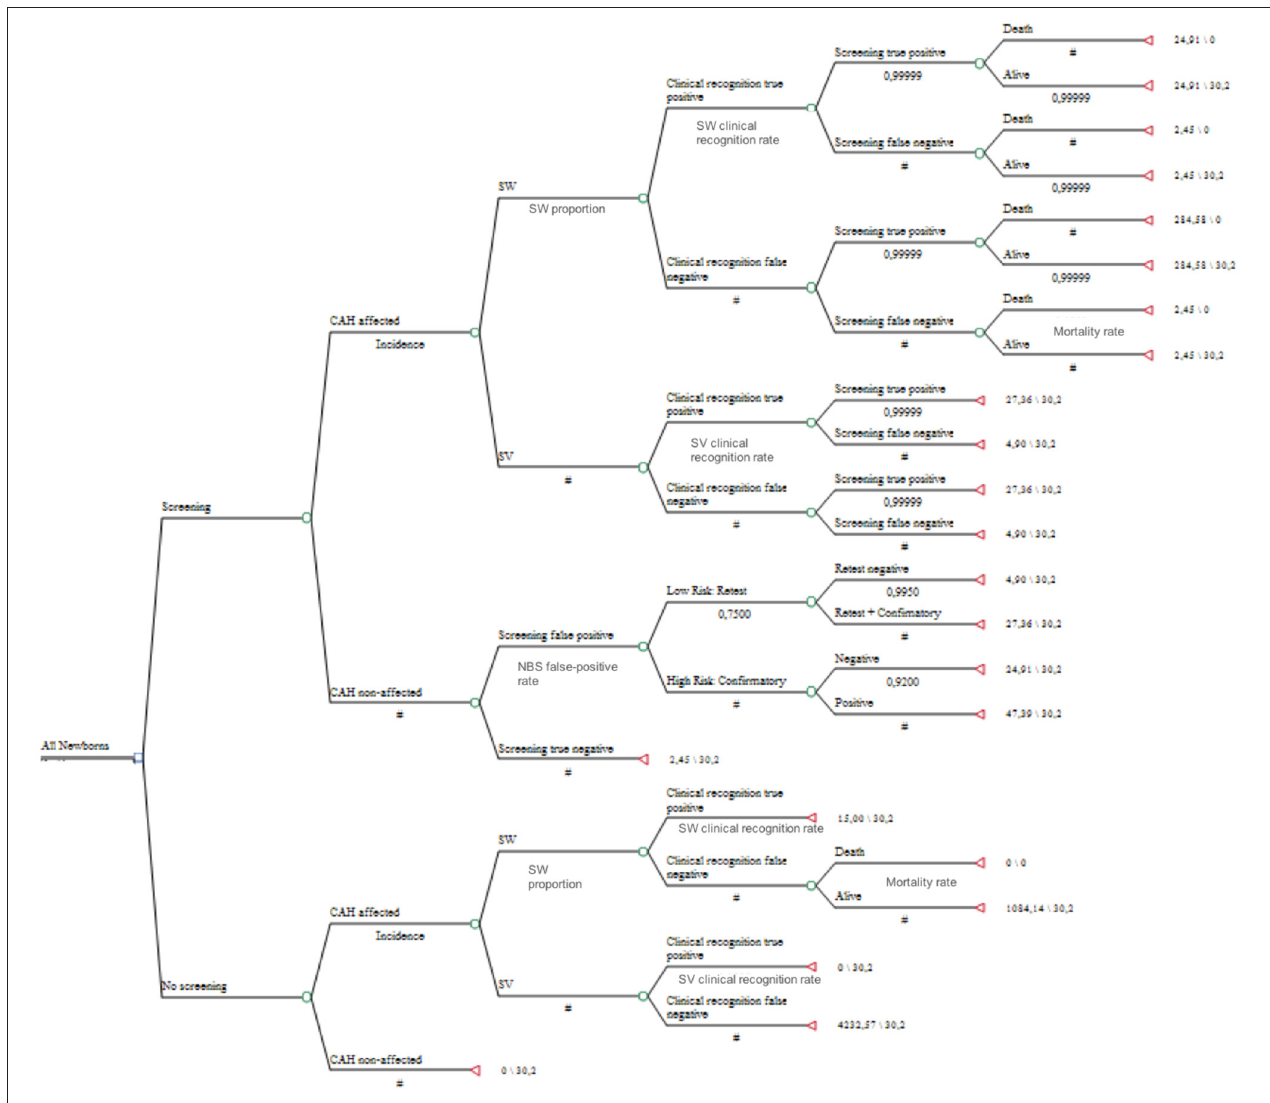
FIGURE 1 | The design of the decision tree